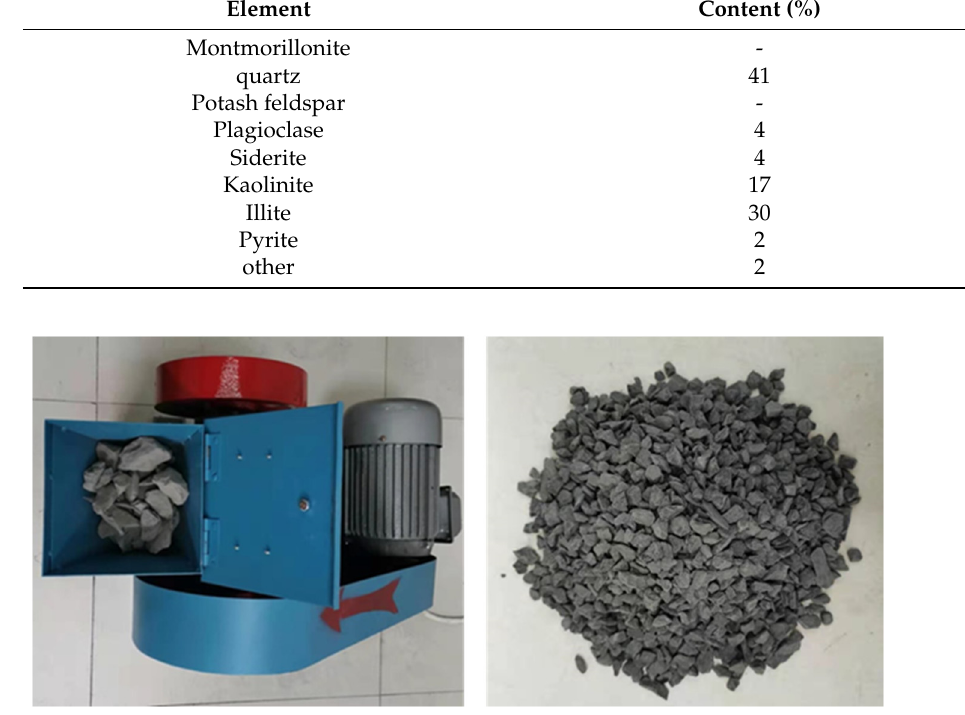
Figure 3. Crushing and screening of